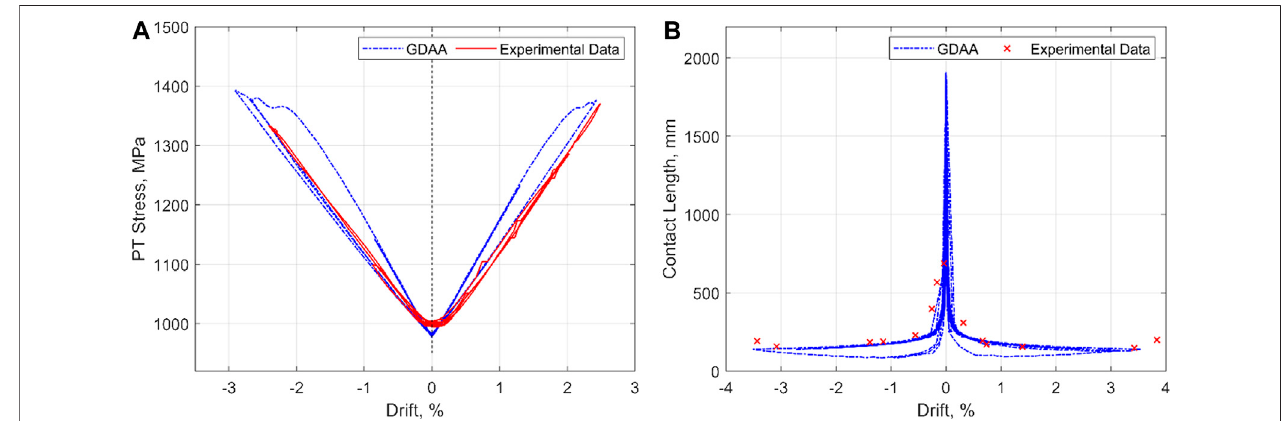
FIGURE 9 | Local responses of GDAA in comparison with the experimental data during Sylmar: (A) Variation of PT Stress, PreWEC-2; (B) Variation of Contact Length, SRW2.